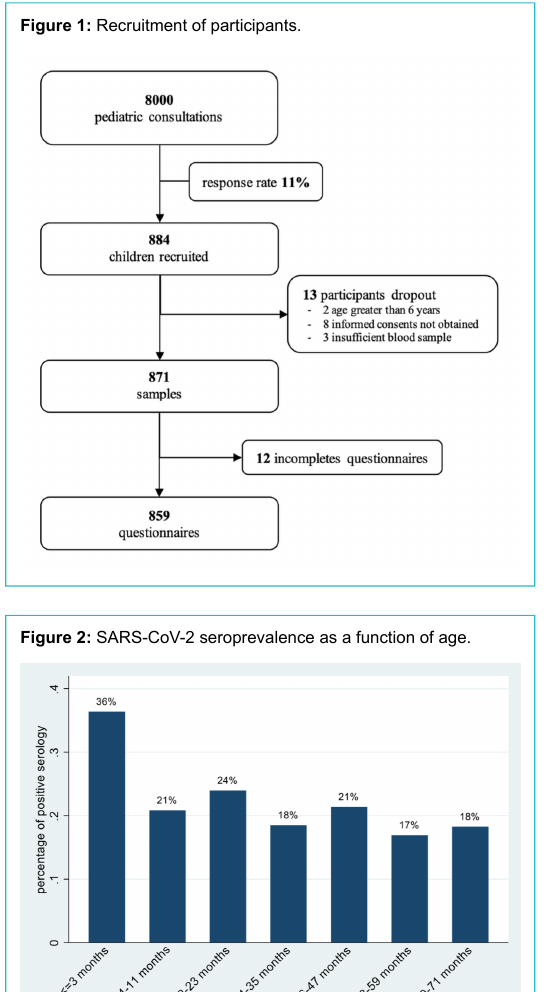
Figure 1: Recruitment of participants.